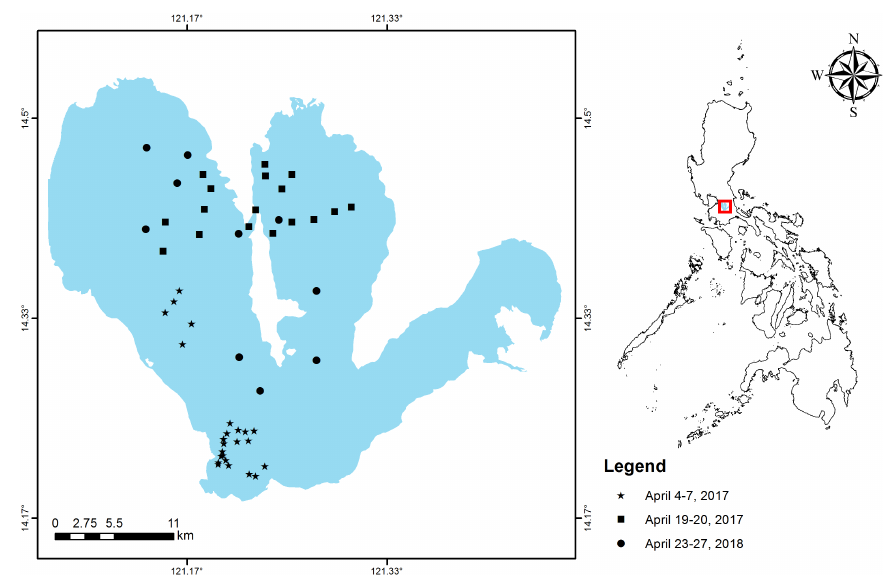
Figure 1. Map of the Philippines (right) and the distribution of sampling sites across the South, West and Central Bay of Laguna de Bay